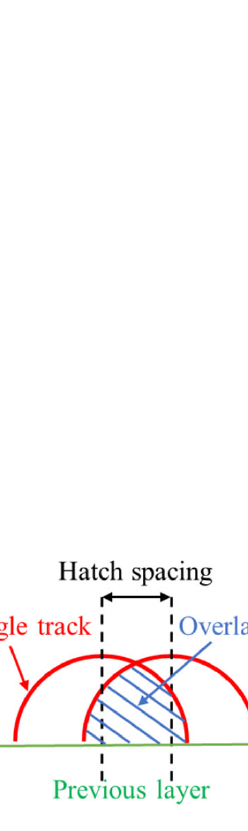
Figure 6. Schematic diagram illustrating the effect of hatch spacing on area of overlap region: ( a ) low hatch spacing; ( b ) suitable hatch spacing; ( c ) high hatch spacing. Reprinted with permission from ref. [43]. Copyright 2020 Elsevier.